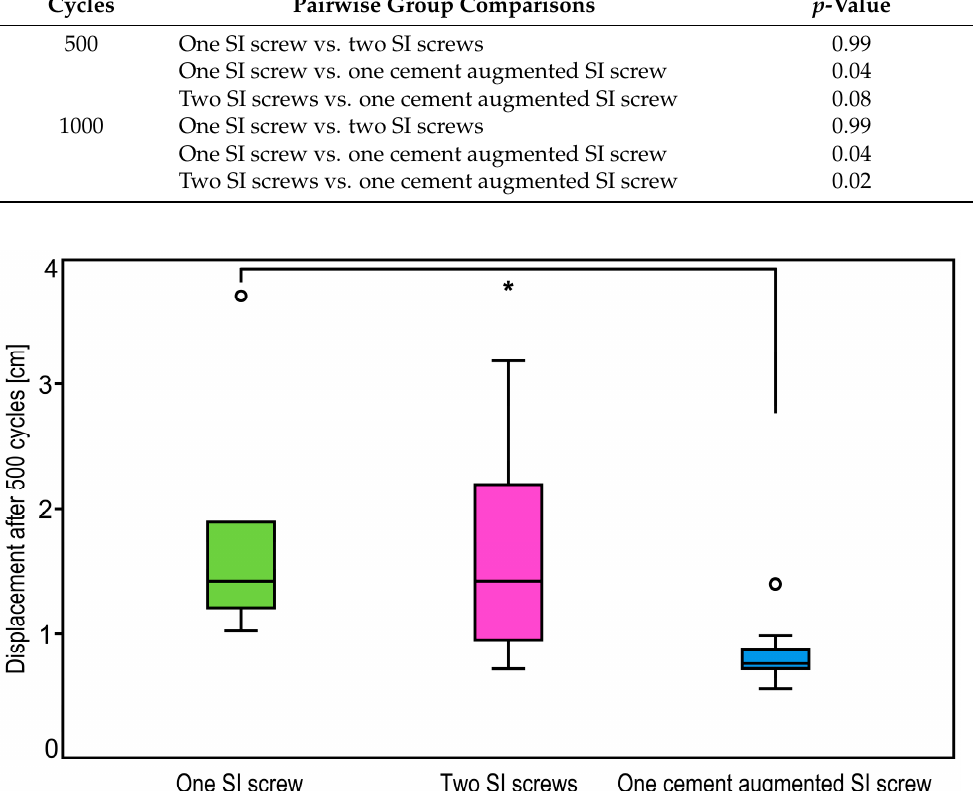
Table 1. p -Values from pairwise comparisons of fracture displacement after 500 and 1000 cycles. Cycles Pairwise Group Comparisons p -Value